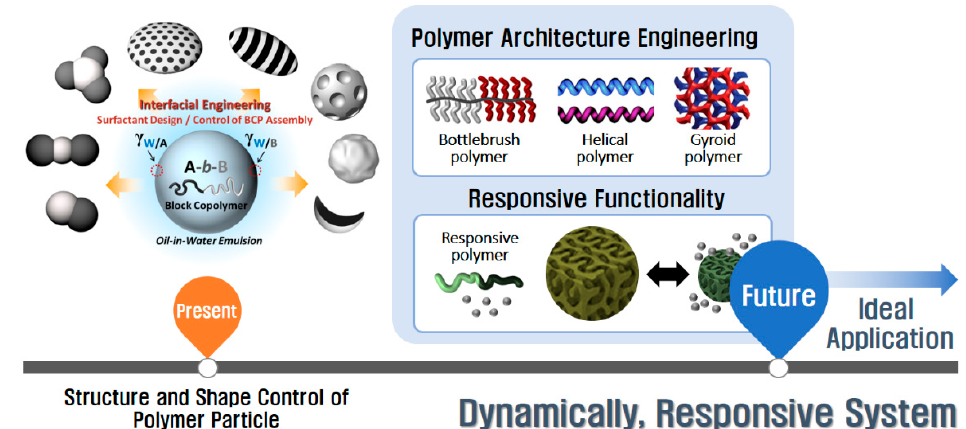
Figure 9. Remaining important challenges and directions for dynamically responsive nanostructured polymer particles. Funding: This work was supported by a grant from Chungnam National University.